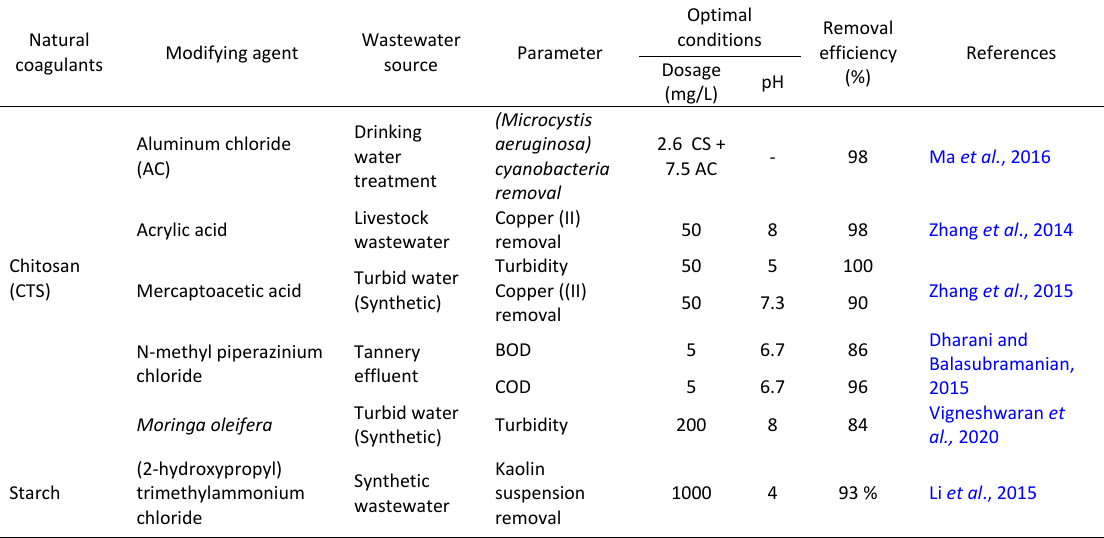
Table 6: Summary of the literary works on the modified natural coagulants Natural